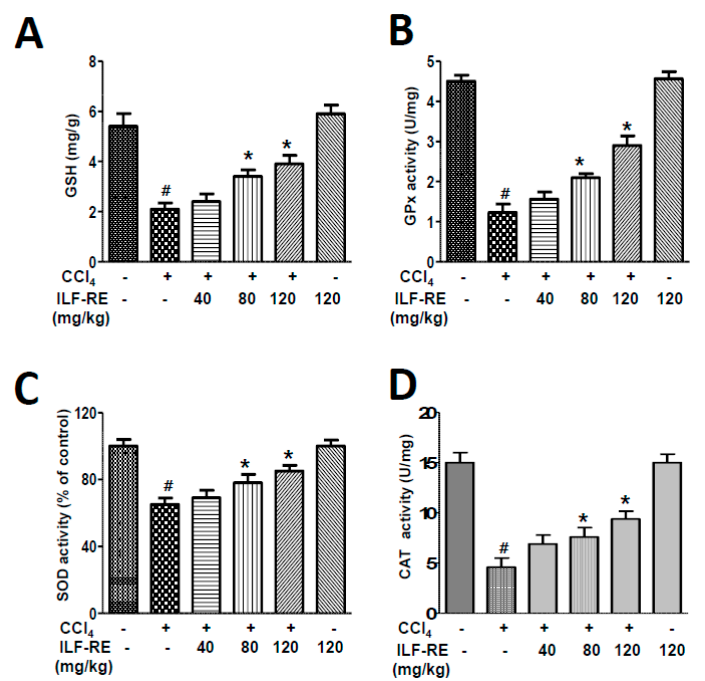
Figure 3. ILF-RE regulates antioxidant activity in CCl 4 -induced hepatotoxicity. Rats were intraperitoneally administered CCl 4 (0.2 mL/100 g, BW) twice a day for 4 weeks. ILF-R (40, 80, or 120 mg/kg) was co-administered with CCl 4 or 120 mg/kg ILF-RE only for 4 weeks, followed by harvesting of the livers. GSH ( A ), GPx ( B ), SOD ( C ), and CAT ( D ) activities were determined. The experiments were performed in triplicate with tissues from at least three rats in each group. # p < 0.05 vs. Con group; * p < 0.05 vs. CCl 4 group ( n = 10 rats per group). BW, body weight; Con, control; CCl 4 , carbon tetrachloride; ILF-RE, the combination R. verniciflua (ILF-R) with E. ulmoides (ILF-E); GSH, glutathione; GPx, glutathione peroxidase; SOD, superoxide dismutase; CAT: Catalase.